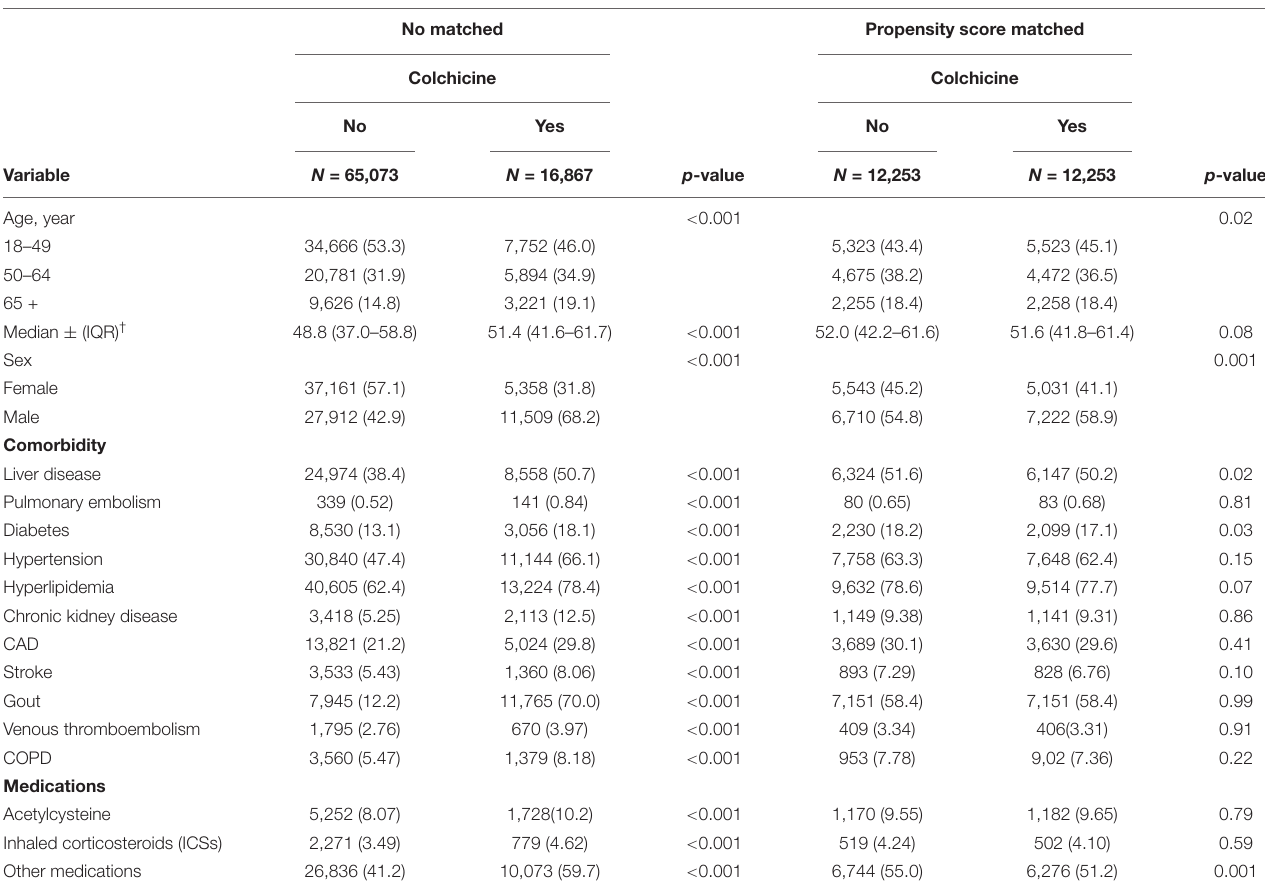
TABLE 2 | Demographic characteristics and comorbidities in the propensity-score-matched cohorts with and without colchicine used among patients with interstitial lung disease with viral infection. No matched Propensity score matched Colchicine